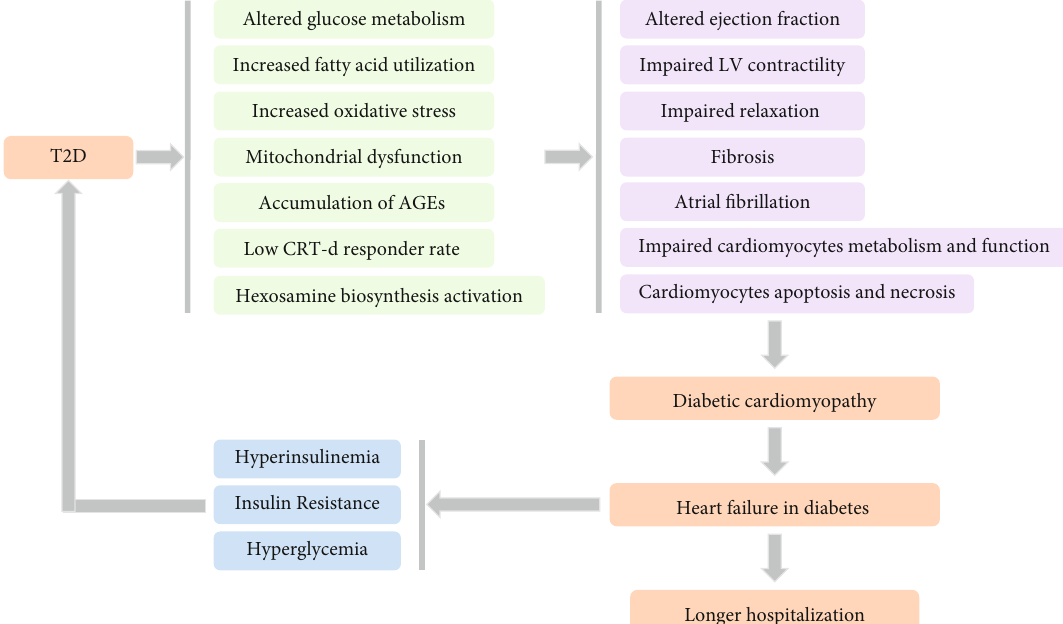
Figure 1: The e ff ects of type 2 diabetes (T2D) in patients with heart failure (HF). Patients with T2D can lead to altered glucose metabolism, increased fatty acid utilization and oxidative stress, mitochondrial dysfunction, accumulation of advanced glycation end products (AGEs), lower cardiac resynchronization therapy with de fi brillator (CRT-d) responder rate, and hexosamine biosynthesis activation. These e ff ects cause altered ejection fraction, impaired left ventricular (LV) contractility, impaired relaxation, heart fi brosis, atrial fi brillation, impaired cardiomyocytes metabolism and function, cardiomyocytes apoptosis, and necrosis, all of which contribute to diabetic cardiomyopathy, leading to increased heart failure in diabetes. T2D patients with HF present longer hospitalization and a higher rate of hyperinsulinemia, insulin resistance, and hyperglycemia, which can further exacerbate T2D